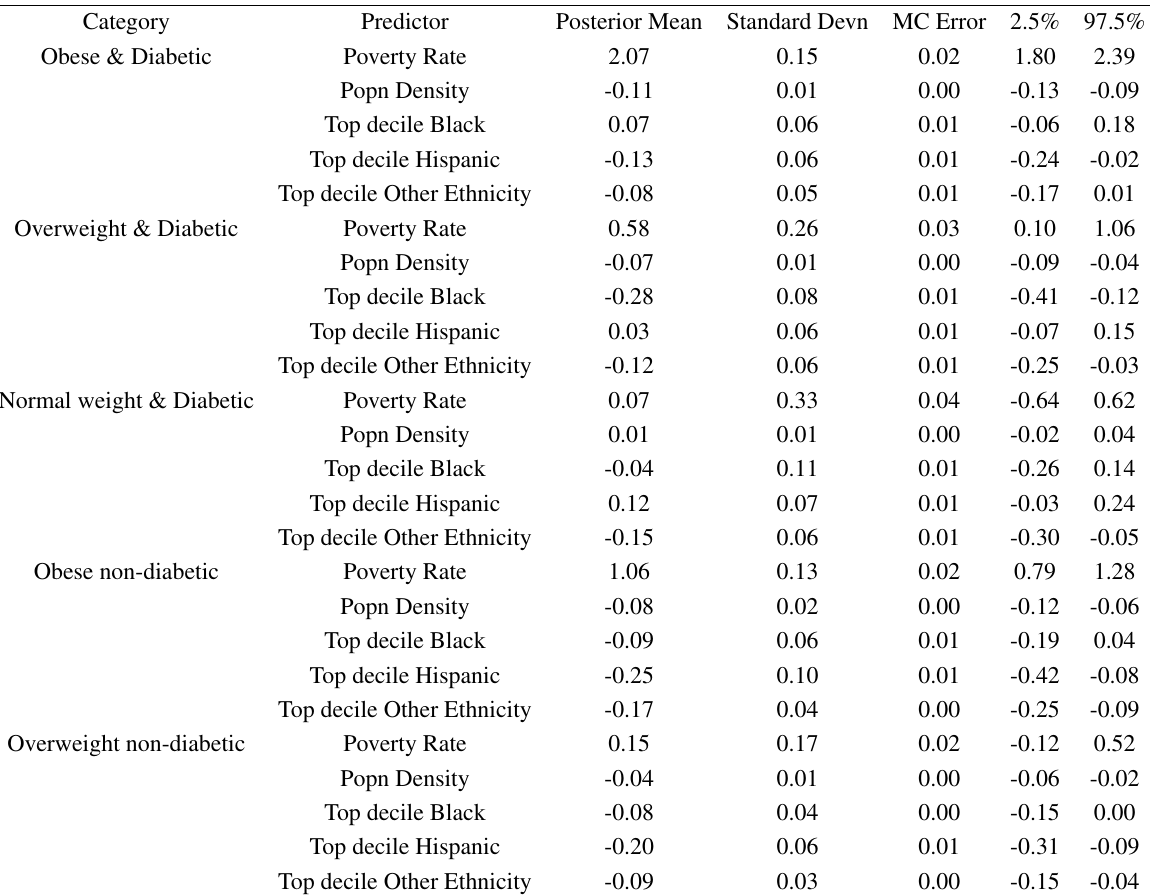
Table 8 . Effects of county predictors by diabetes-weight category, model 3. Category